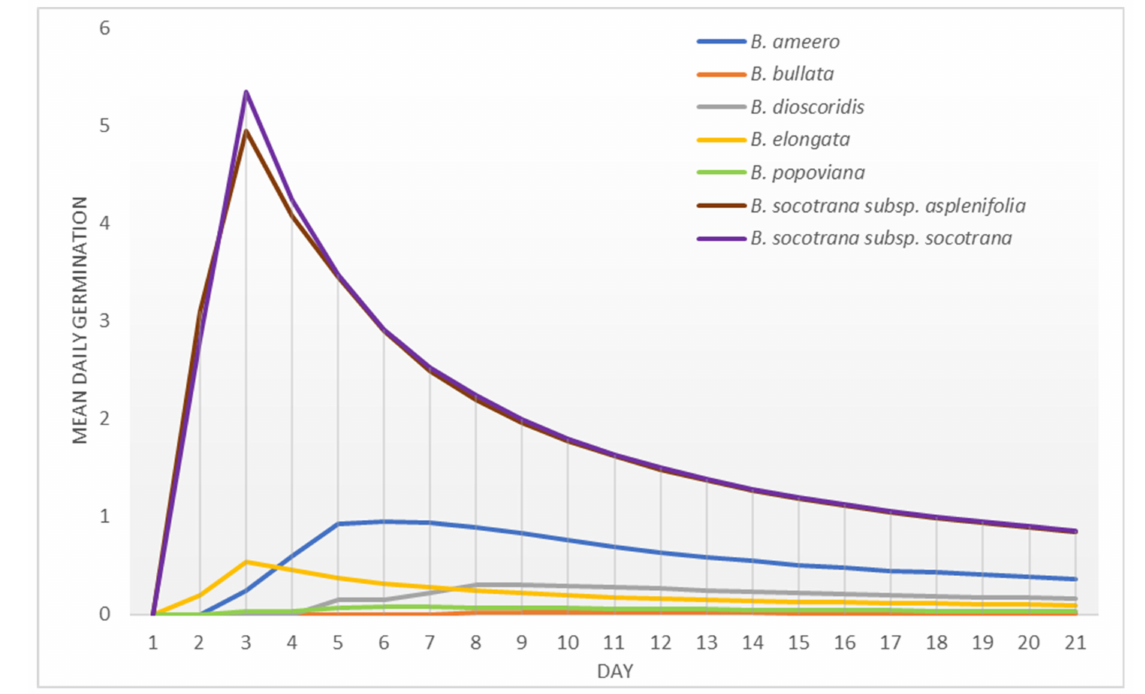
Figure 8. Peak value indexes of seeds of different Boswellia taxa from Socotra sampled in 2020.